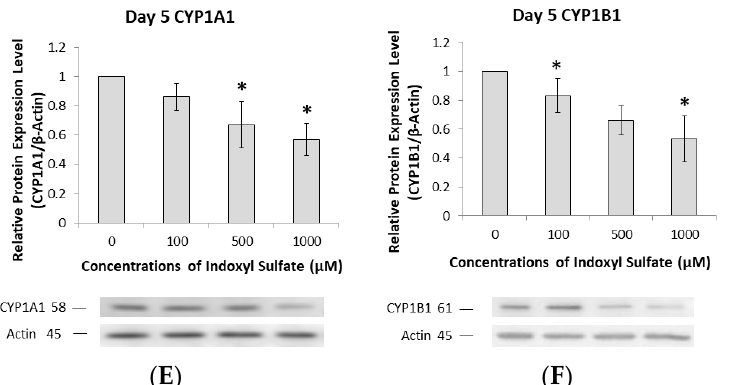
Figure 2. Effects of low IS concentrations on AhR transcription, nuclear translocation, and CYP enzyme production in osteoclasts. Raw 264.7 cells with 50 ng / mL of sRANKL were cultured in IS at 0, 100, 500, and 1000 µ M for 3 and 5 days. ( A ) Low IS concentrations increase AhR nuclear translocation on Day 3. Immunofluorescence with an anti-AhR antibody revealed that the most AhR localization (green) occurs in the cytoplasm with 0 and 1000 µ M IS. White arrows indicate that AhR is present in the cytoplasm and not the nucleus. Red arrows indicate that AhR is present in both the cytoplasm and nucleus (at 100 µ M IS). A representative example from three independent experiments is shown. ( B ) Average ratio of AhR nuclear translocation in immunofluorescence images for each group on Day 3; the highest percentage was at 100 µ M IS. Error bars represent mean ± SD ( n = 5). * p < 0.05 compared to control group. # p < 0.05 compared to 100 µ M IS. ( C , D ): CYP1A1 and CYP1B1 expression, respectively, at di ff erent IS concentrations on Day 3. Western blot analysis showed that low IS concentrations (100 µ M) increased CYP1A1 and CYP1B1 expression, while high IS concentrations ( > 500 µ M) inhibited CYP1A1 and CYP1B1 expression. Error bars represent mean ± SD ( n = 3). * p < 0.05 compared to the control group. # p < 0.05 compared to 100 µ M IS. ( E ) and ( F ): CYP1A1 and CYP1B1 expression, respectively, at di ff erent IS concentrations on Day 5. Western blot analysis showed that IS treatment inhibited CYP1A1 and CYP1B1 expression in a dose-dependent manner. Error bars represent mean ± SD ( n = 3). * p < 0.05 compared to the control